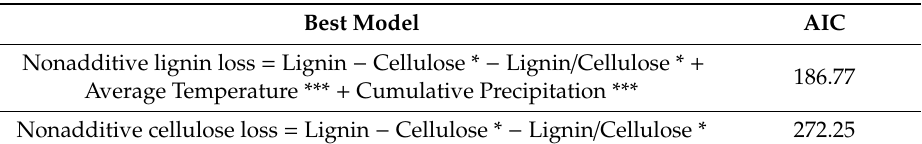
Table 2. Summary of the generalized linear models for the e ff ects of changing litter quality and environmental factors on the nonadditive loss of lignin and cellulose.